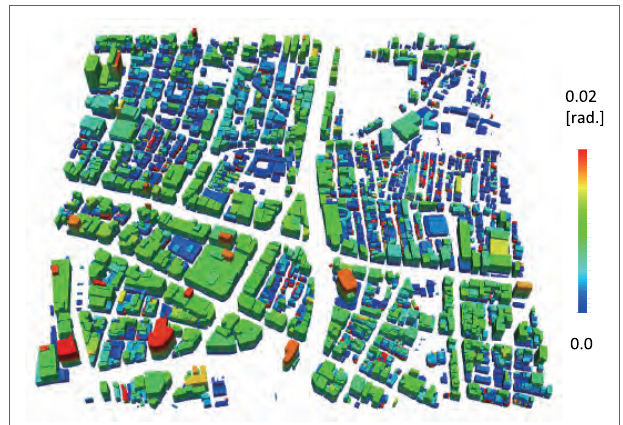
FigUre 9 | Distribution of MSDA.